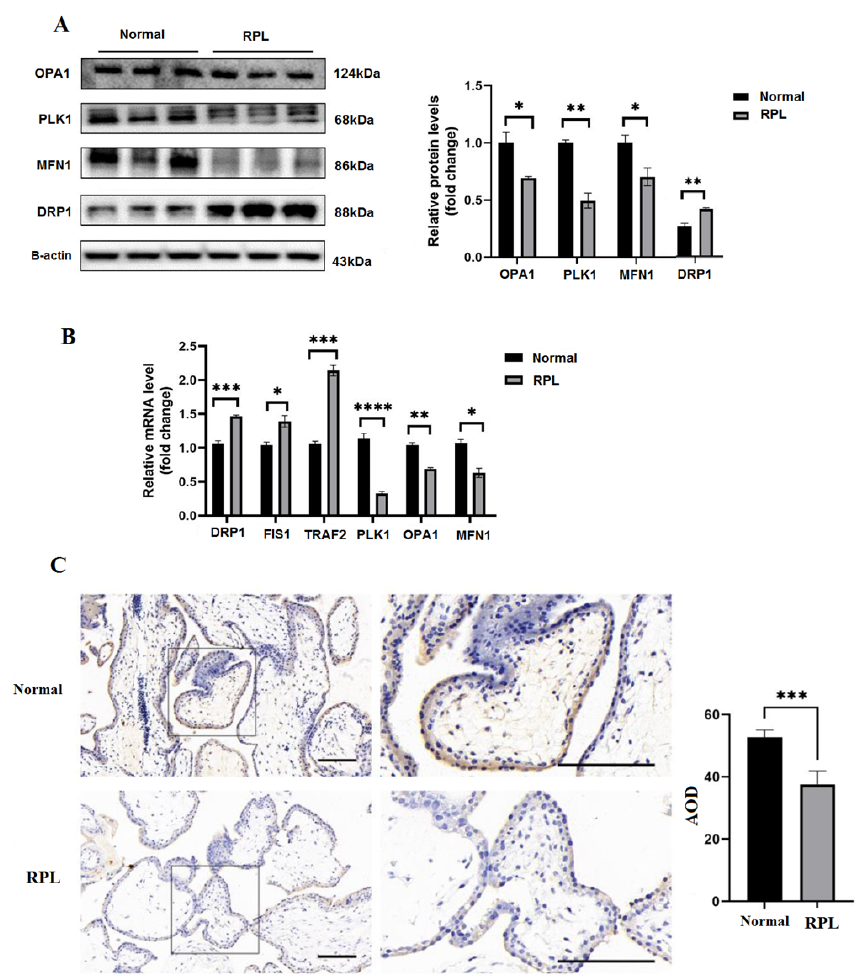
Figure 2. Hub genes dysregulation: ( A ) WB exhibited a change in the expressions of PLK1, DRP1, MFN1, and OPA1; ( B ) qRT-PCR analysis of hub genes, such as PLK1 , DRP1 , TRAF2 , MFN1 , and OPA1 ; ( C ) IHC staining images of the RPL samples and the healthy group; * p < 0.05, ** p < 0.01, *** p < 0.001, **** p < 0.0001.